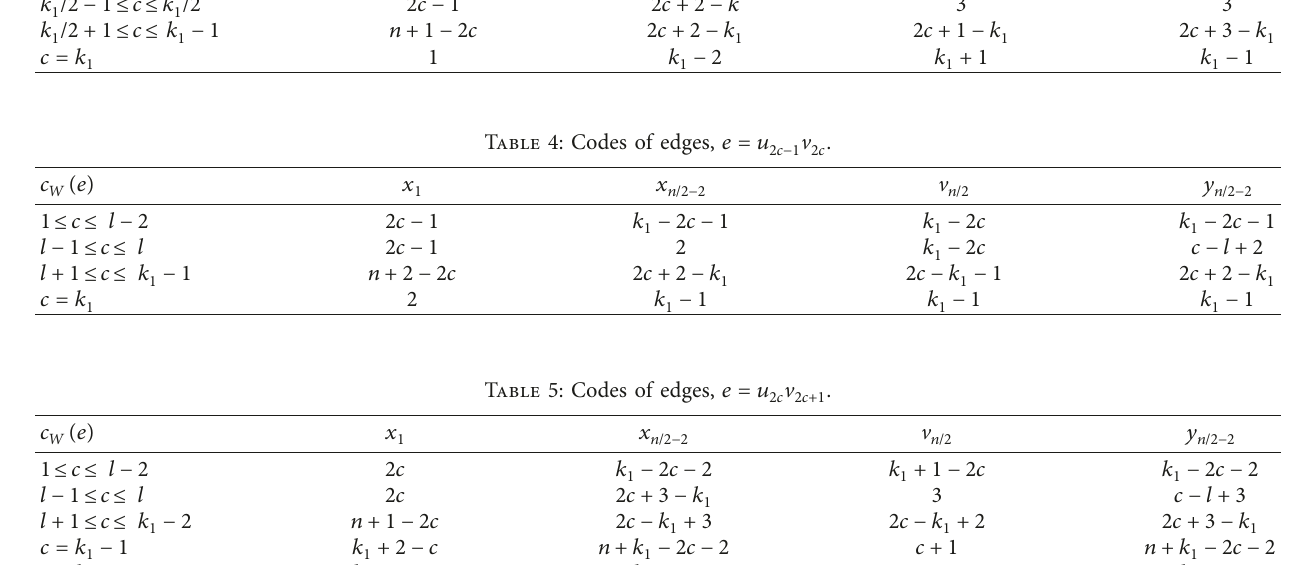
Table 3: Codes of edges, e � x